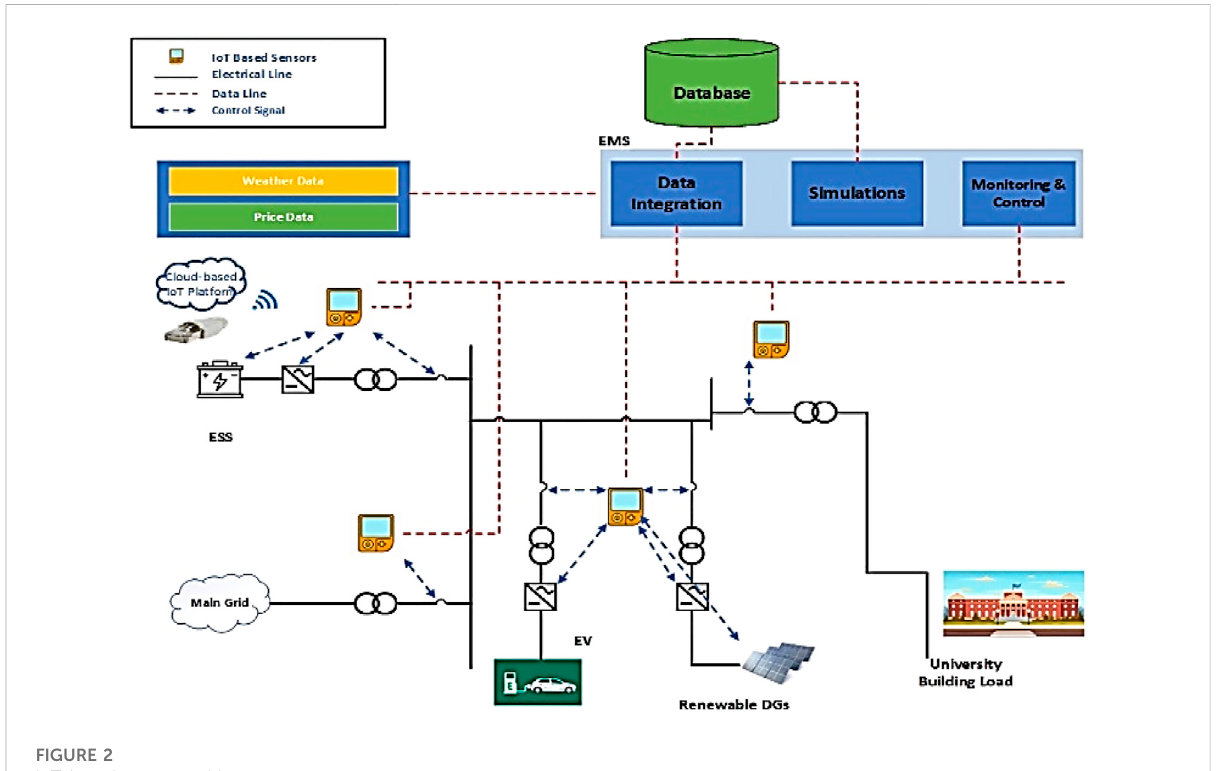
FIGURE 2 IoT-based system